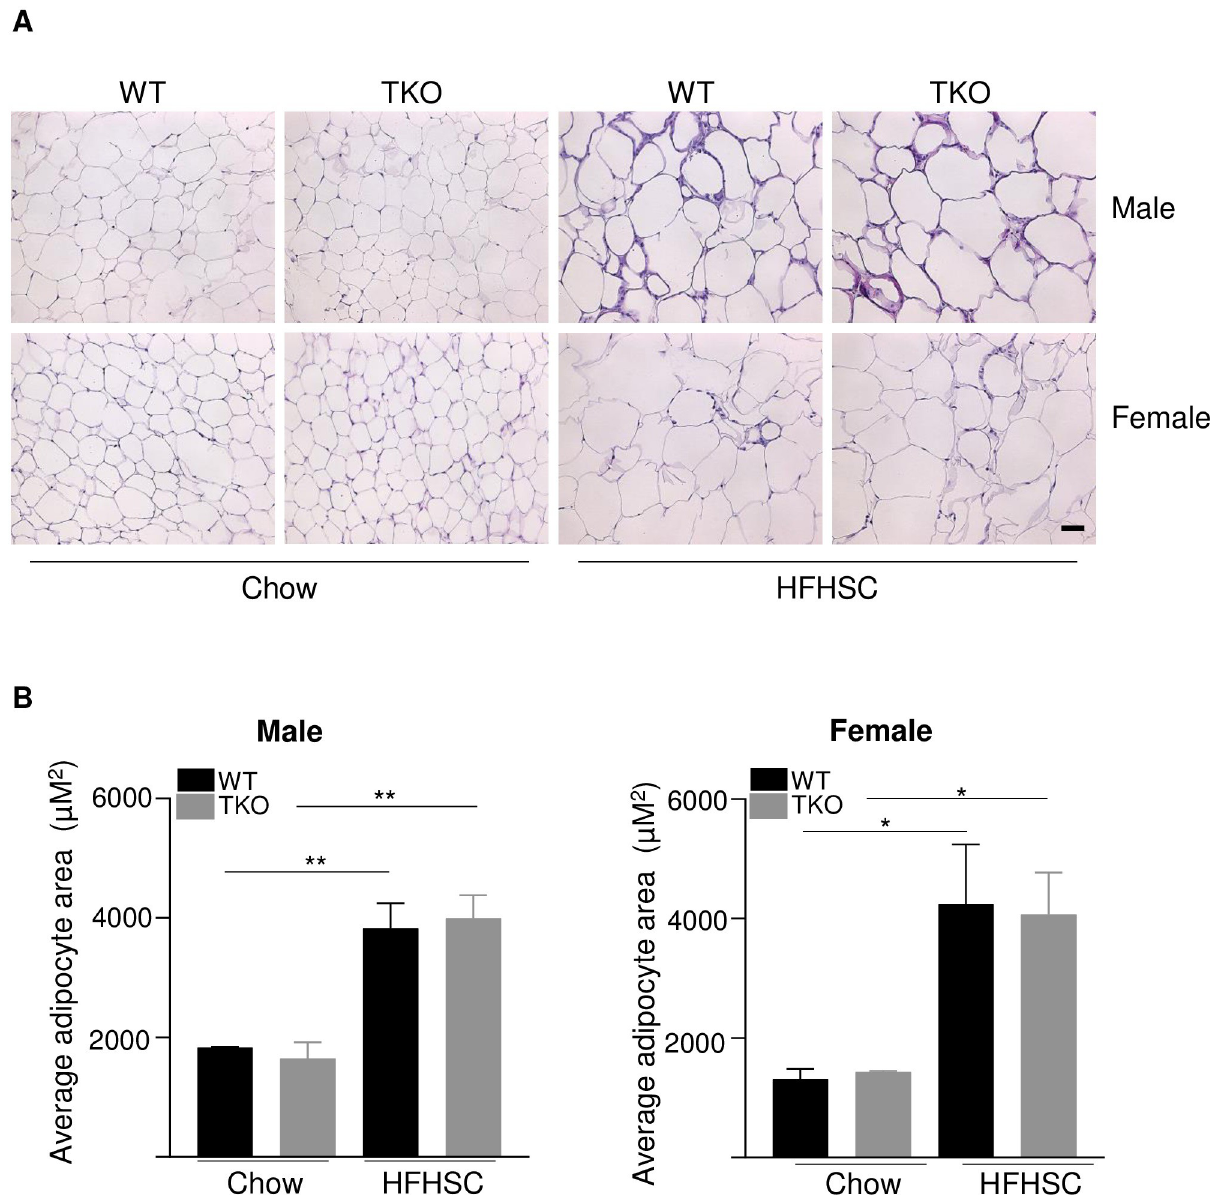
Fig 7. Deficiency of SAA does not affect diet-induced changes in adipose tissue structure. A) Representative images of HE staining in gonadal white adipose tissues in male and female WT and TKO mice fed either chow or HFHSC diet for 16 weeks. Scale bar 50 μ m. B) adipocyte area was determined for 3 randomly chosen sections for 3 mice/strain; male (left) and female (right) mice; data are mean ± SEM;. � and �� = P � 0.05 and � 0.01